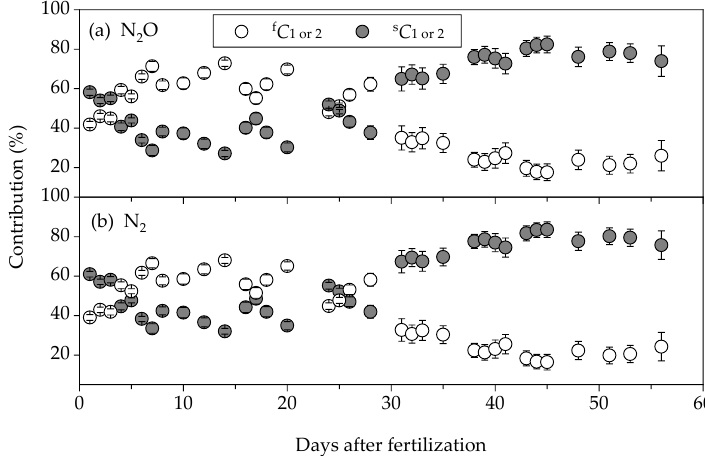
Figure 6. Contributions of ammonium-based fertilizer ( f C 1 , f C 2 ,) or soil ( s C 1 , s C 2 ) nitrogen (N) to ( a ) nitrous oxide (N 2 O) and ( b ) dinitrogen (N 2 ) emissions from a cultivated black soil subjected to a cool temperate climate. The observational period and meaning of each error bar are found in the footnotes of Figures 2 and 3, respectively.